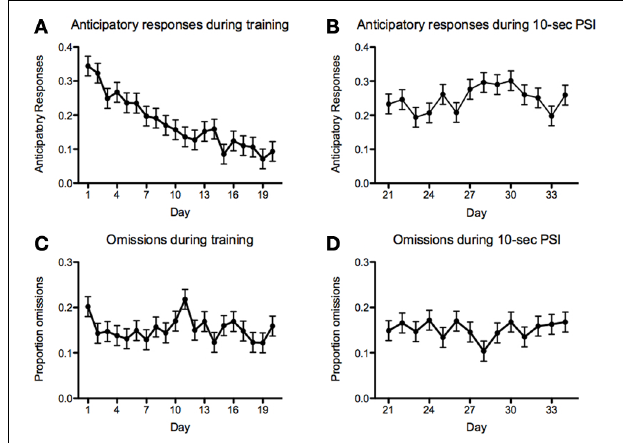
FIGURE 9 | Anticipatory responses and omissions. Proportion of anticipatory (i.e., responding prior to the onset of the stimulus) responses (A,B) and omissions (C,D) during the 5 (A,C) - and 10 (B,D) -second PSI phases for all fish tested. Note: N =